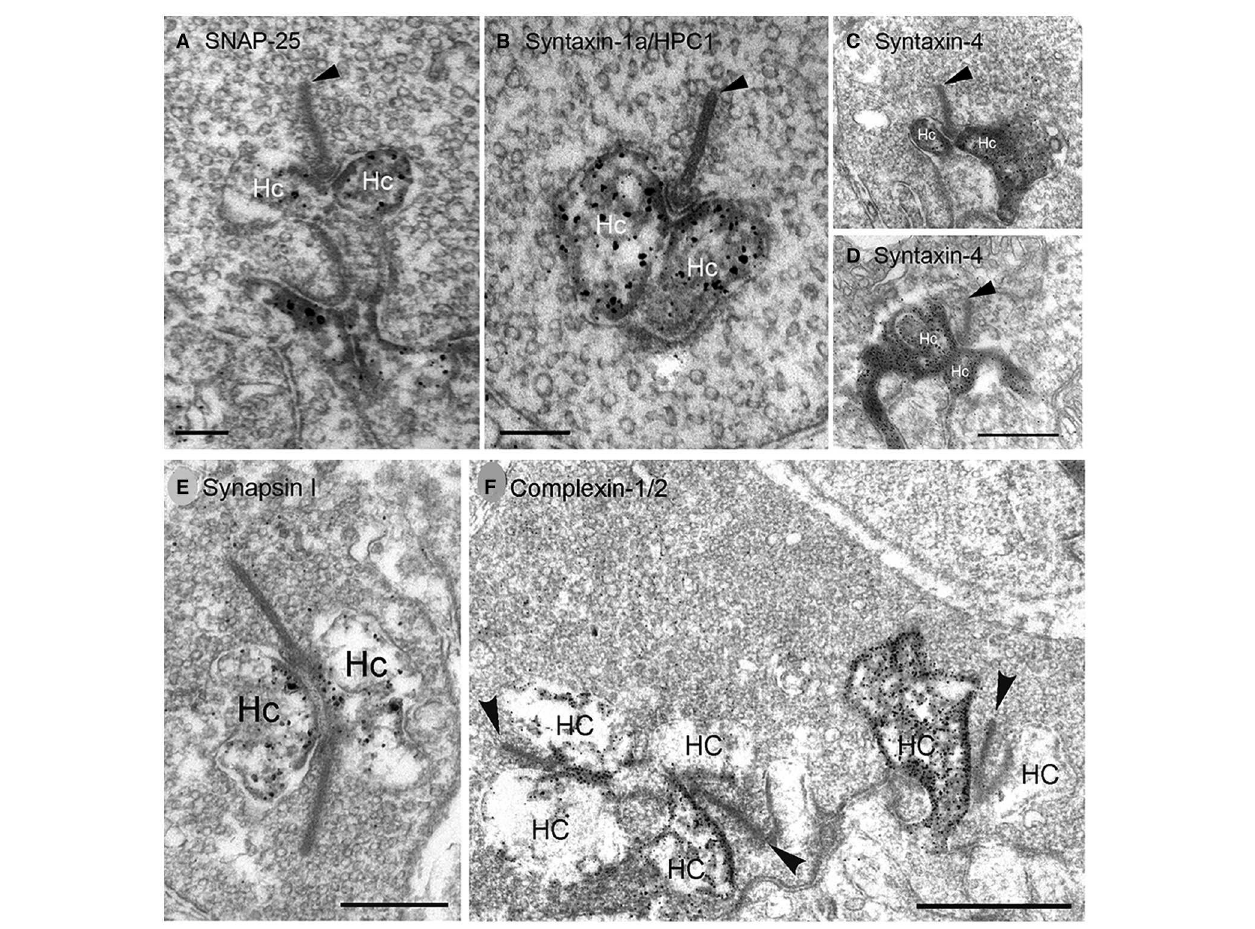
FIGURE 6 | SNARE complex and synaptic proteins localize to horizontal cell synaptic endings. Pre-embedding immunoelectron microscopy with antibodies to (A) SNAP-25, (B) syntaxin-1a/HPC1, (C,D) syntaxin-4, (E) synapsin I, (F) complexin-1/2 produced dark, granular DAB immunolabeling for each SNARE ( A–D , SNAP-25, syntaxin-1a, syntaxin-4) or synaptic protein ( E,F , synapsin I, complexin-1/2) in horizontal cell (Hc) endings at (A–E) rod photoreceptor synapses. (F) Complexin-1/2 labeling of lateral elements at cone photoreceptor synapses. Arrowheads point to synaptic ribbons. (A,B,E,F) , rabbit retina; (C,D) , mouse retina. Scale bars, 0.2 µ m in (A) , 0.3 µ m in (B) , 0.5 µ m in (C,D) , 0.4 µ m in (E) , 1 µ m in (F) . (Modified from (A) Hirano et al., 2011; (B,E,F) Hirano et al., 2005; (C,D) Hirano et al.,